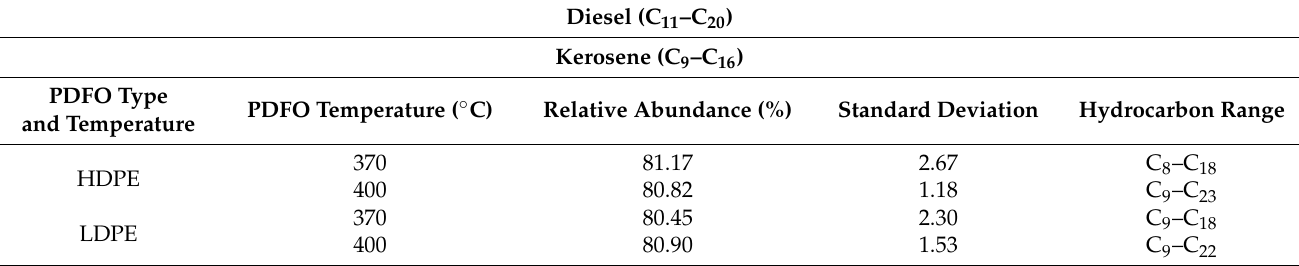
Table 1. Summary of predominant hydrocarbons in PDFO as a function of temperature and plastic type.